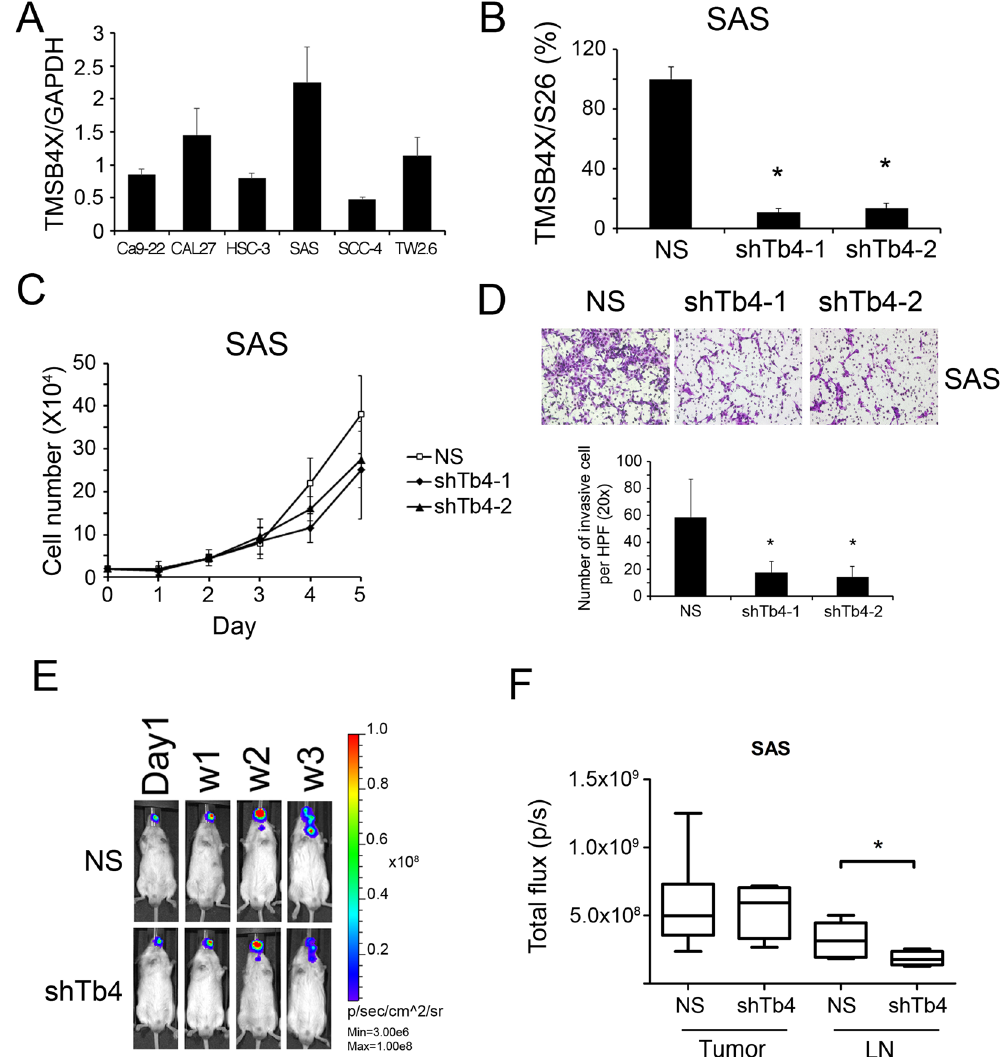
Figure 5. Cell function assays. Knockdown TMSB4X in SAS cells may inhibit their cell proliferation and invasion ability in vitro , as well as suppress cervical LN metastasis in vivo . ( A ) The panel of TMSB4X expression level in 6 HNSCC cell lines by RT-PCR. The relative aggressive SAS cells have abundant TMSB4X. ( B ) In TMSB4X knockdown clones of SAS, the expression was revealed by RT-PCR. ( C ) The growth curves of TMSB4X knockdown clones of SAS. ( D ) The invasion ability of TMSB4X knockdown clones of SAS was performed by Boyden chamber assay. Cell photography and number were taken and counted at 200x magnification (high power field, HPF). ( E ) Bioluminescence images were taken from the buccal orthotopic xenograft mouse model. The total flux of bioluminescence was measured separately at mouse buccal (Tumor) and neck lymph node (LN metastasis). ( F ) The box-plot of LN metastasis was drawn according to the total flux value in region of interest (ROI). Asteroid * denotes P < 0.05. Statistics was calculated by student t-test. (shTb4- 1: clone1 with